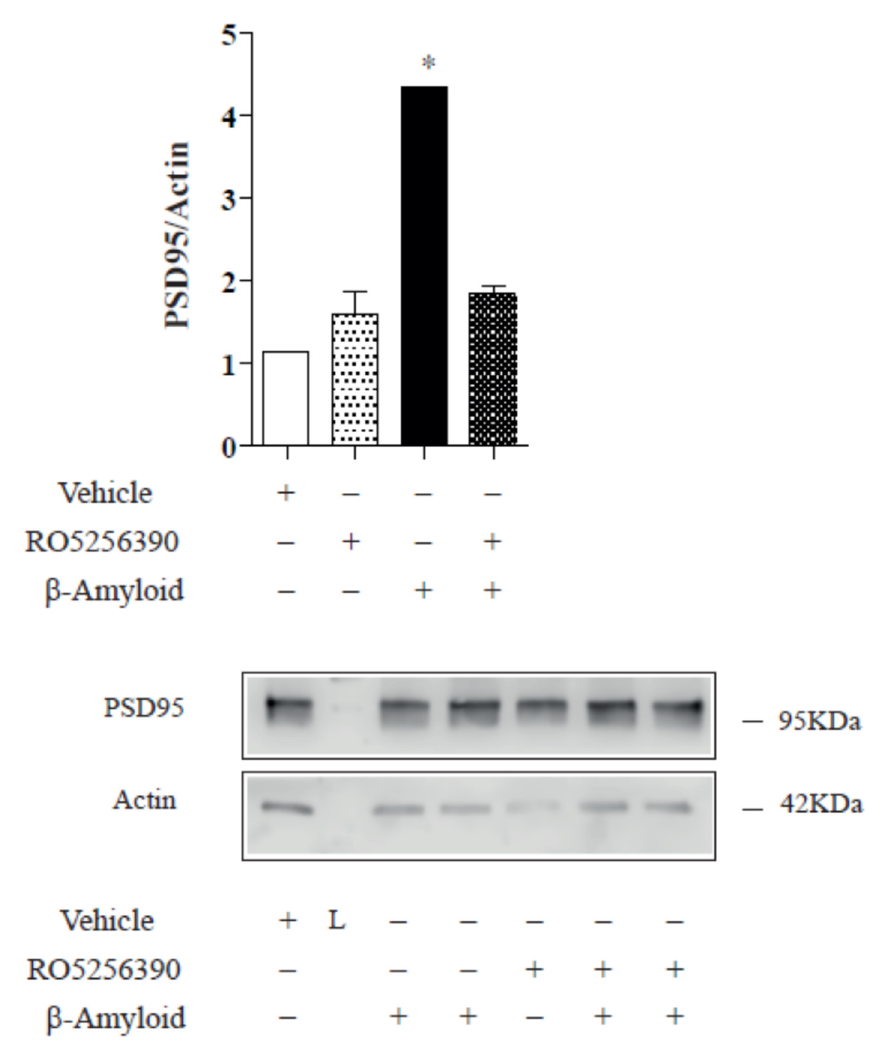
Figure 3. TAAR1 activation induces an increase in PSD-95 protein expression. The TAAR 1 agonist demonstrated the ability to increase the PSD amount in control cortical cells 14 DIV. Representative Western blot images. Results are representative of three different cell cultures (* p < 0.05).